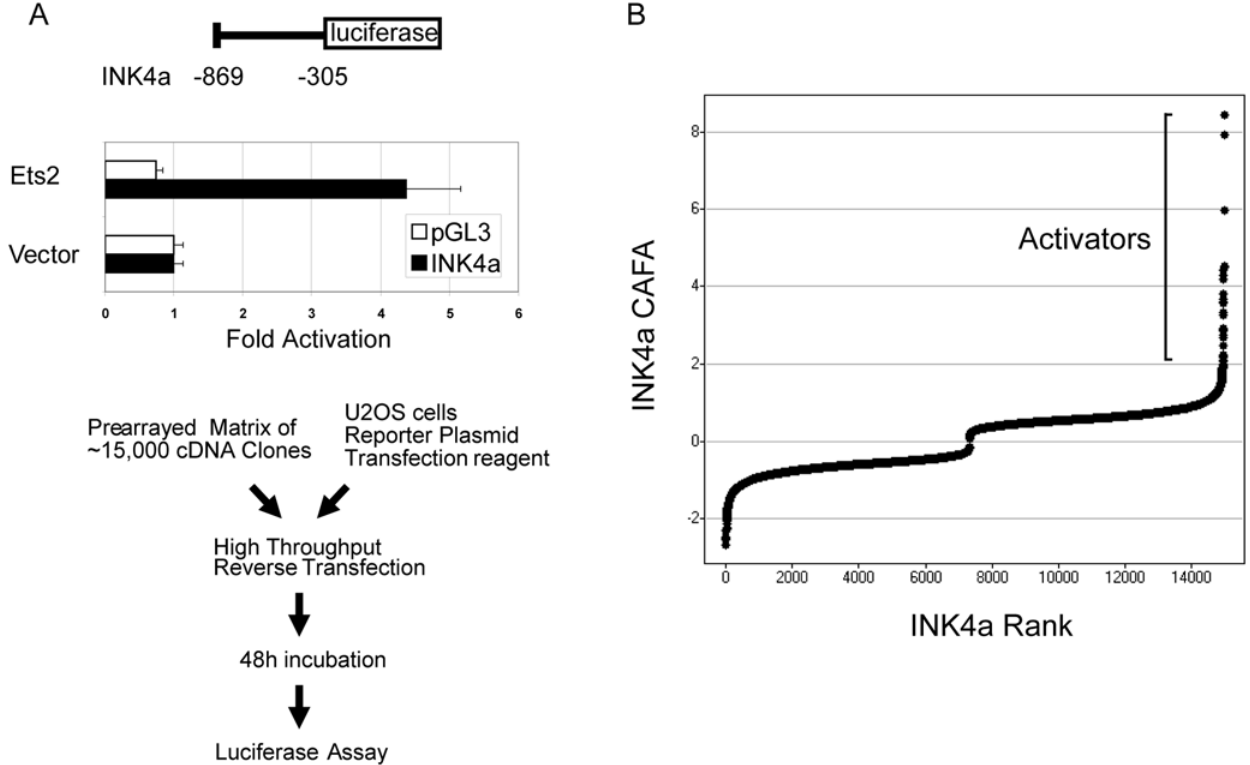
Figure 1. Transcriptional activators of INK4A identified by a functional genomics screening approach. (A) Screening strategy. Numbering indicates portion of the INK4a regulatory region, relative to the natural translational start site, inserted into the pGL3 luciferase reporter. Validation of the reporter was performed by cotransfection in U2OS cells under screening conditions. Mean luciferase values from four replicates are shown; error bars represent one standard deviation. (B) Screen results. Luciferase values from duplicate wells were normalized by plate, transformed and scaled to generate relative activity values (see Materials and Methods), then plotted according to rank.